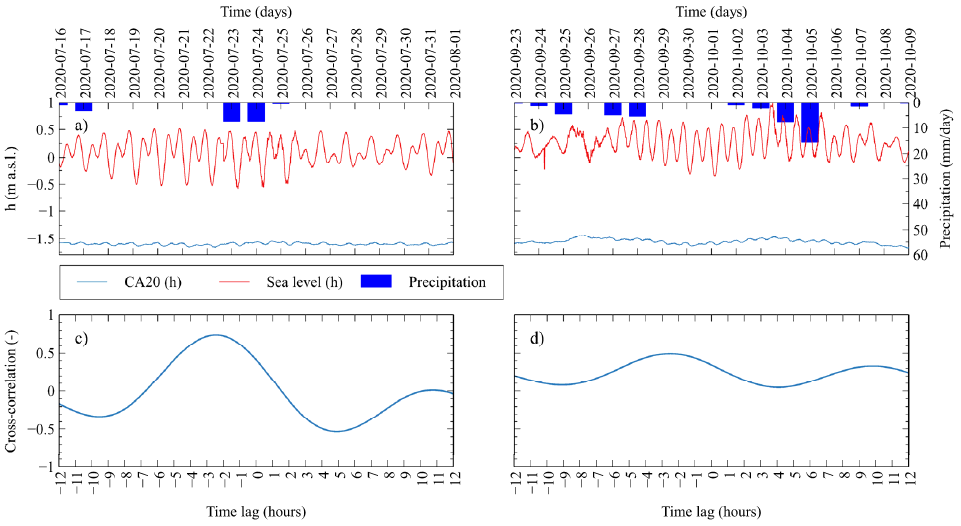
Figure 12. Detailed short-term analysis for ( a ) 16 July 2020 10:00am–01 August 2020 09:50am and ( b ) 23 September 2020 03:00pm–09 October 2020 08:00am; ( c ) and ( d ) are the cross-correlation